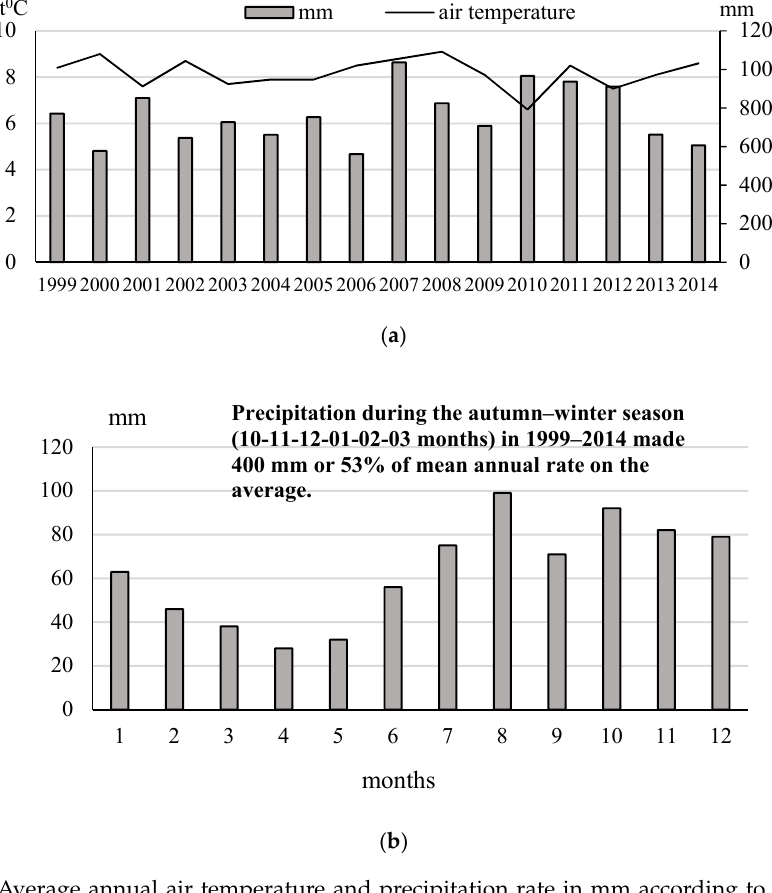
Figure 2. Average annual air temperature and precipitation rate in mm according to the Krantas